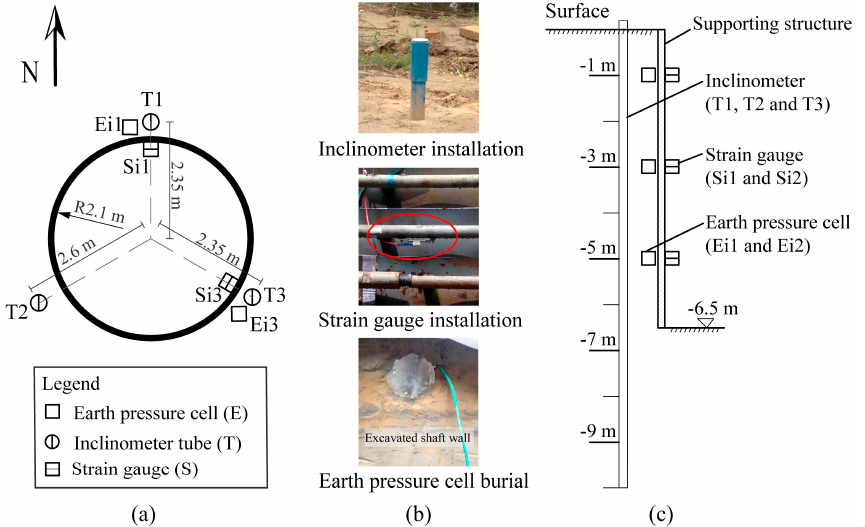
Figure 5. Distribution and installation of instruments: ( a ) Plan layout of the monitoring points; ( b ) photo of the instrument installation; and ( c ) cross-sectional view of the monitoring points. (The letter, ‘i’ represents the depth of the instruments).